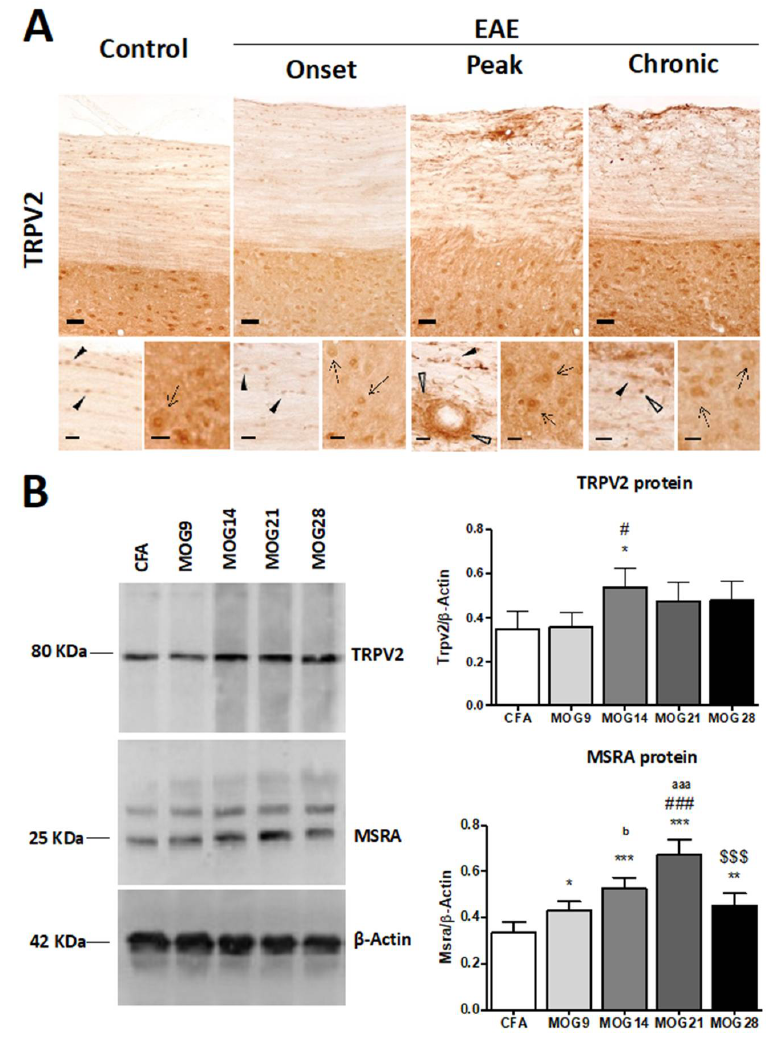
Figure 5. TRPV2 expression in spinal cord samples from WT and EAE mice. ( A ) Immunohistochemical staining of TRPV2 in spinal cord of control and EAE-induced mice in the onset, peak and in the chronic phase, during remission. In control conditions, TRPV2 is expressed in neurons in GM (inset, arrows), and in oligodendrocytes in WM (inset, arrowheads). After EAE induction, an increase in TRPV2 expression is mainly located in inflammatory focuses at the peak clinical symptomatology in WM (empty arrowheads). ( B ) MSRA and TRPV2 protein expression in thoracic spinal cord samples from CFA and MOG mice (9, 14, 21 and 28 days post-immunization). ( B ) A significant increase in TRPV2 protein levels (#, p = 0.0014) is determined in MOG14 mice when compared with CFA ( p < 0.05) and when compared with MOG9 ( p < 0.05). A significant increase ( p < 0.05) in MSRA protein levels is observed in all groups of mice treated with MOG when compared with CFA mice, as well as between different groups treated with MOG: MOG9 vs. MOG21 (###, p < 0.001), MOG9 vs. MOG14 ( b , p < 0.05), MOG21 vs. MOG28 ( $$$ , p < 0.001), MOG14 vs. MOG21 ( aaa , p < 0.001). Bars show mean ± SEM; * p < 0.05, ** p < 0.01 and *** p < 0.001 vs. CFA using one-way ANOVA and Newman–Keuls post-test. Scale bars = 50µm; (insets) = 20µm. 2.6. MSRA and TRPV2 Gene and Protein Expression are Modified in Frontal Cortex Samples of MS Patients Gene and protein expression of TRPV2 and MSRA was explored in frontal cortex tissue samples of healthy ( n = 4) and MS subjects ( n = 6). In MS subjects, a non-significant